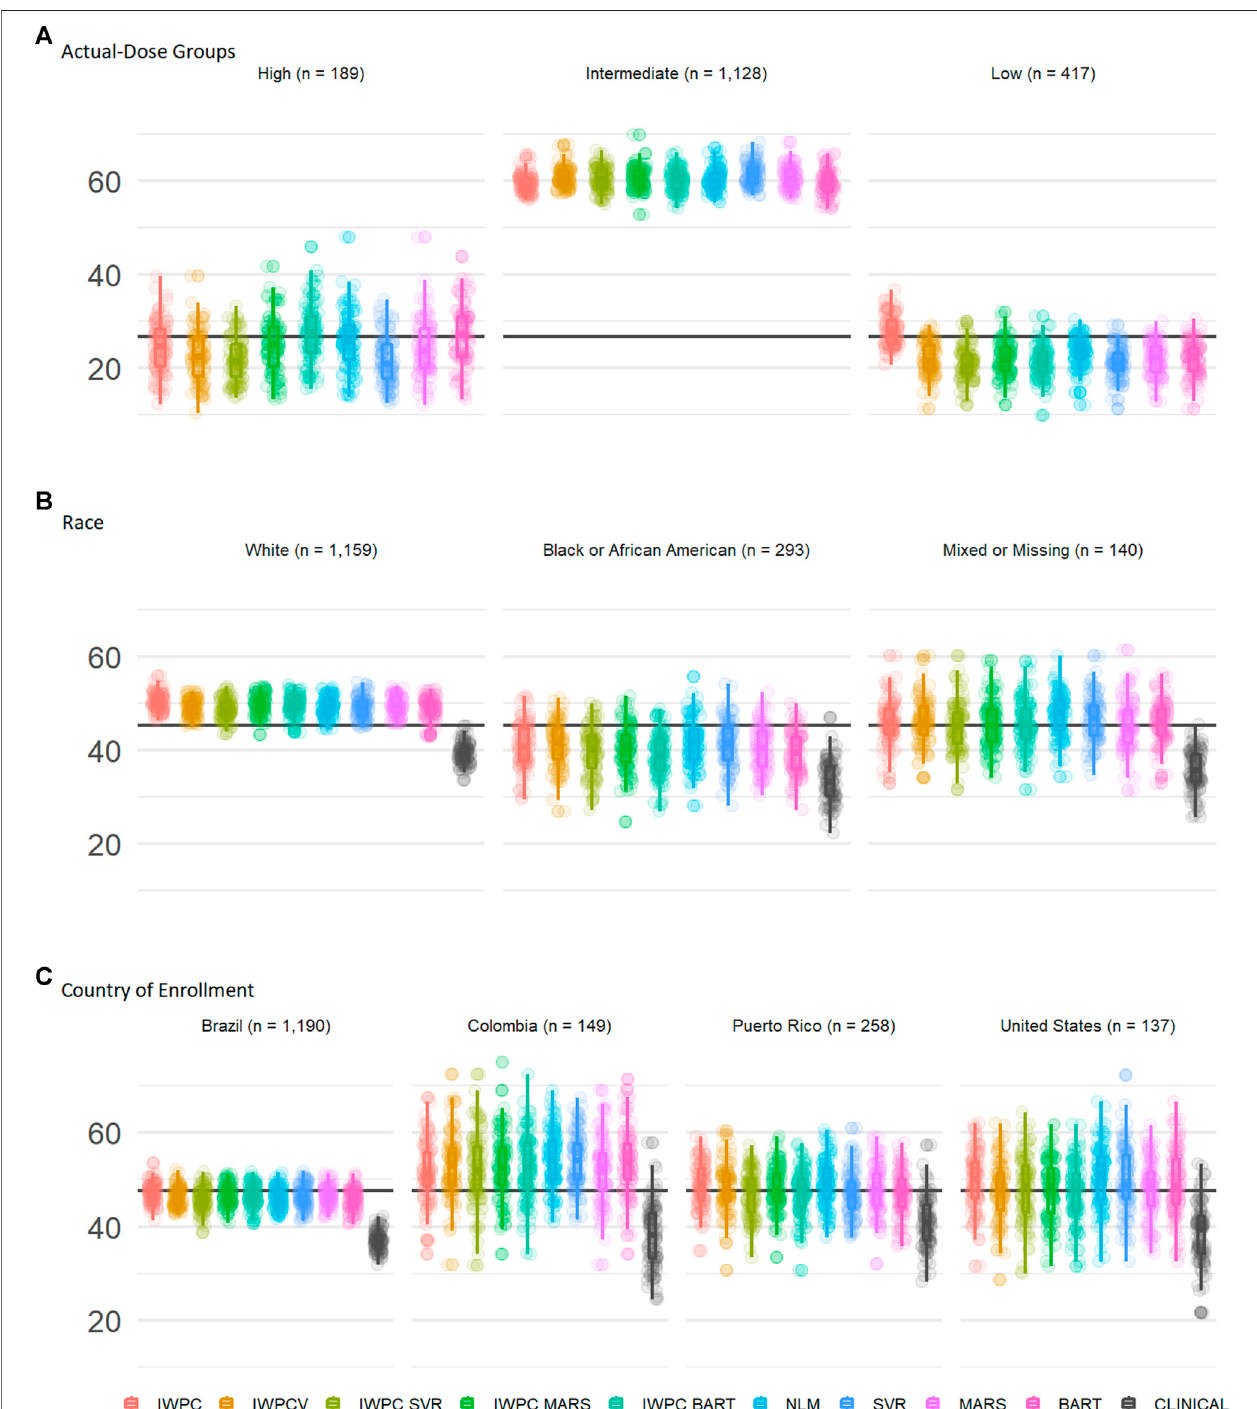
FIGURE3| Subgroup Comparisons ofWarfarinDose PredictionAlgorithmsin the ULLAcohort. Proportion ofpatients predicted within20%oftheir actual dose in theUSLatinosandLatinAmericans(ULLA)cohortby (A) actual-dosegroup, (B) racegroup,and (C) countryofenrollment.Theboxplotvisualizes fi vesummarystatistics (the median, 25 and 75% quartiles and two whiskers at 1.5* Interquartile Range). The points indicate the proportion of patients predicted within 20% at each of the 100 roundsofresampling.Thehorizontallineindicatesthemedianpercentagepredictedwithin20%acrossallparticipants.Fromlefttoright,the fi rst fi vemodels,IWPC, IWPCV, IWPC_SVR, IWPC_MARS, and IWPC_BART feature the clinical variables age, height, weight, race, enzyme inducer user, amiodarone use and the genetic variables CYP2C9 Diplotype and VKORC1- 1639G > A Genotype, the next four models, NLM, SVR, MARS and BART feature the additional variables gender, ethnicity, statin use, aspirin use, history of diabetes, warfarin indication, the last model features only the clinical variables from the fi rst set. IWPC indicates International Warfarin Pharmacogenetics Consortiummodel, IWPCV,IWPCvariables, IWPCMARS,IWPCvariables inaMultivariate AdaptiveRegressionSplines,IWPCSVR,IWPCvariables in a Support Vector Regression, IWPC BART, IWPC variables in a Bayesian Additive Regression Trees, NLM, Novel Linear Model, Clinical, the IWPC Clinical model.